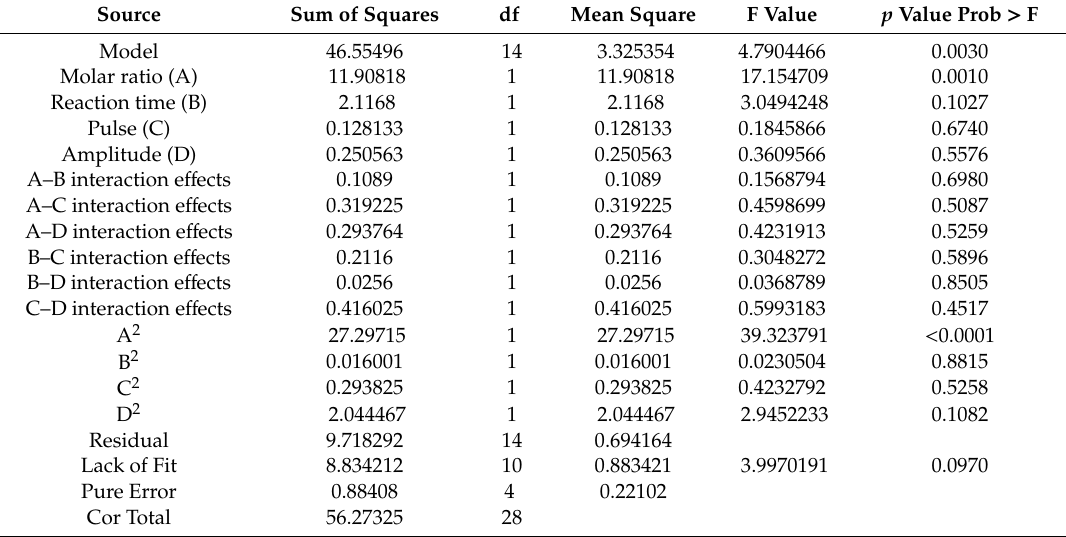
Table 5. ANOVA table of